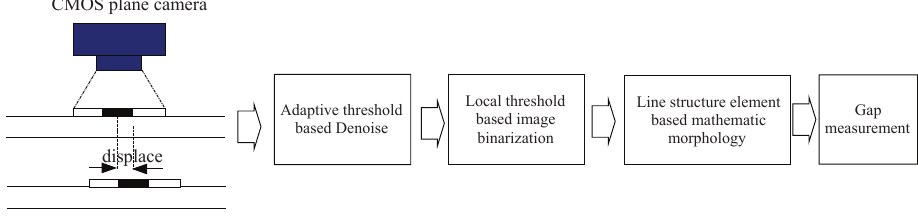
Figure 2. Schematic diagram of the gap